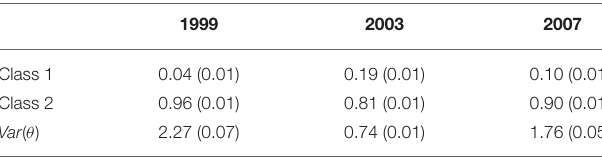
TABLE 4 | Class size for the 21 trended anchor items in 1999, 2003, and 2007 TIMSS using two-class mixture 3PL IRT